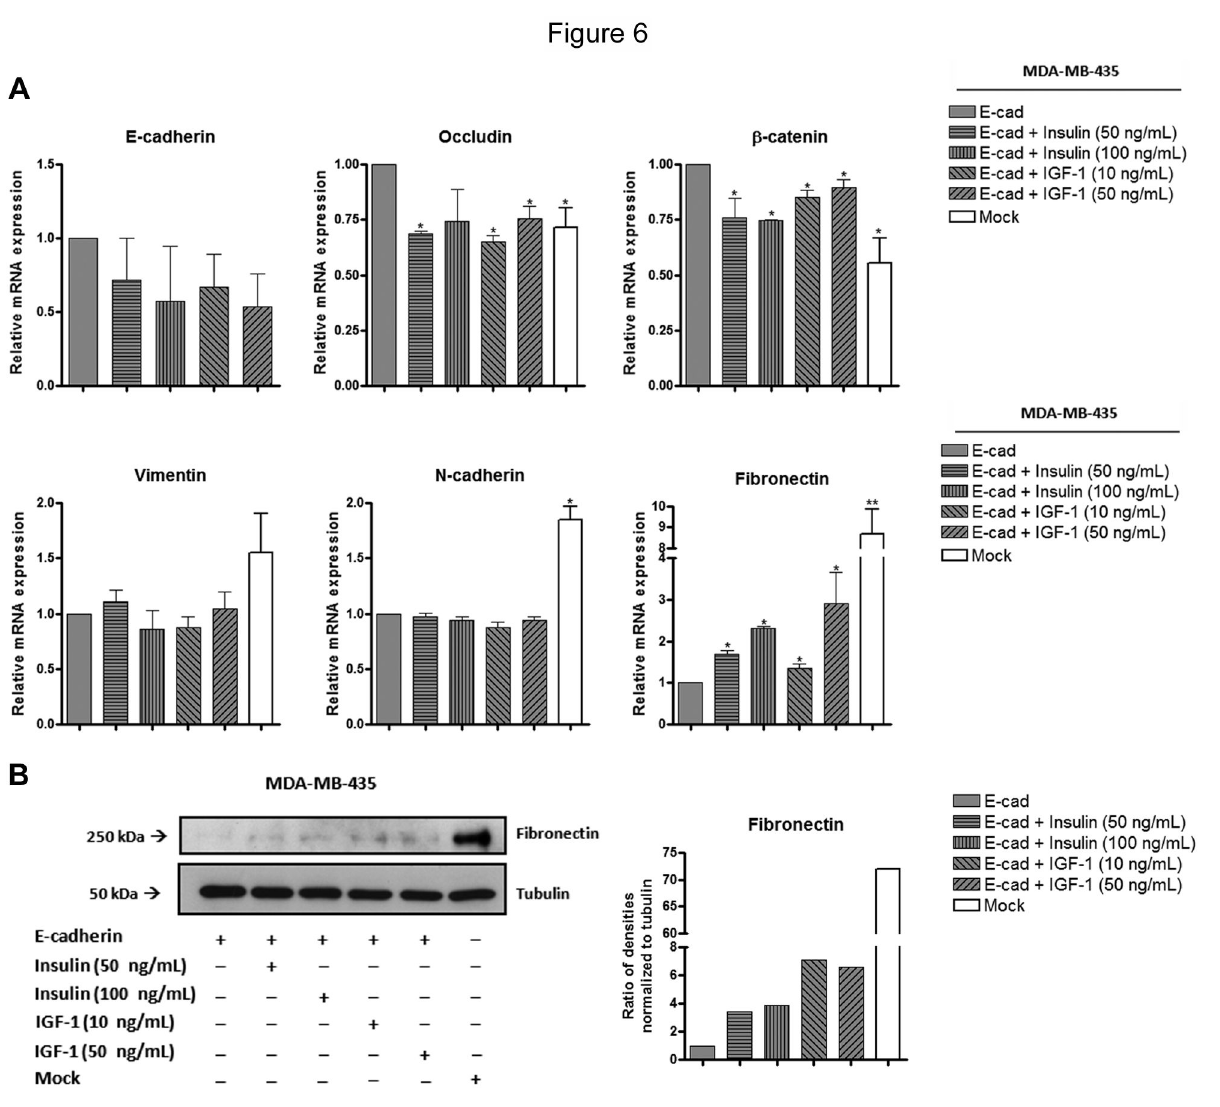
Effects of insulin and IGF-I stimulation on the mRNA expression levels of epithelial and mesenchymal markers. (A) The bar graphs show the relative amount of E-cadherin, occludin, β-catenin, vimentin, fibronectin and N-cadherin mRNA levels by qRT-PCR. Significant down-regulation of the mRNA levels of epithelial markers (occludin and β-catenin) and an up- regulation of the mesenchymal marker fibronectin were observed after insulin and IGF-I stimulation. Values were normalized to the amount of mRNA in MDA-MB-435+E-cad. Error bars indicate the means + S.E.M. (n = 3). * = P < 0.05, ** = P < 0.01, ANOVA test. Effects of stimulation with insulin and IGF-I on the fibronectin protein levels . (B) Total cell lysates from MDA-MB-435+E- cad,MDA-MB-435+E-cad stimulated (24h) with insulin or IGF-1, and MDA-MB-435+mock were obtained and analyzed by Western blot for fibronectin. Increased fibronectin expression levels are observed after stimulation with insulin or IGF-I. The bar graphs show the relative amount of fibronectin levels normalized to